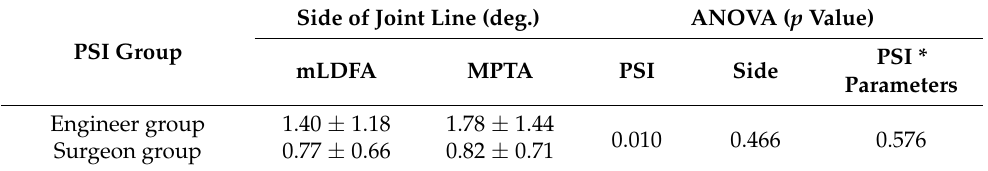
Table 3. The effects of PSI on the absolute deviation of joint line orientation (mean ±